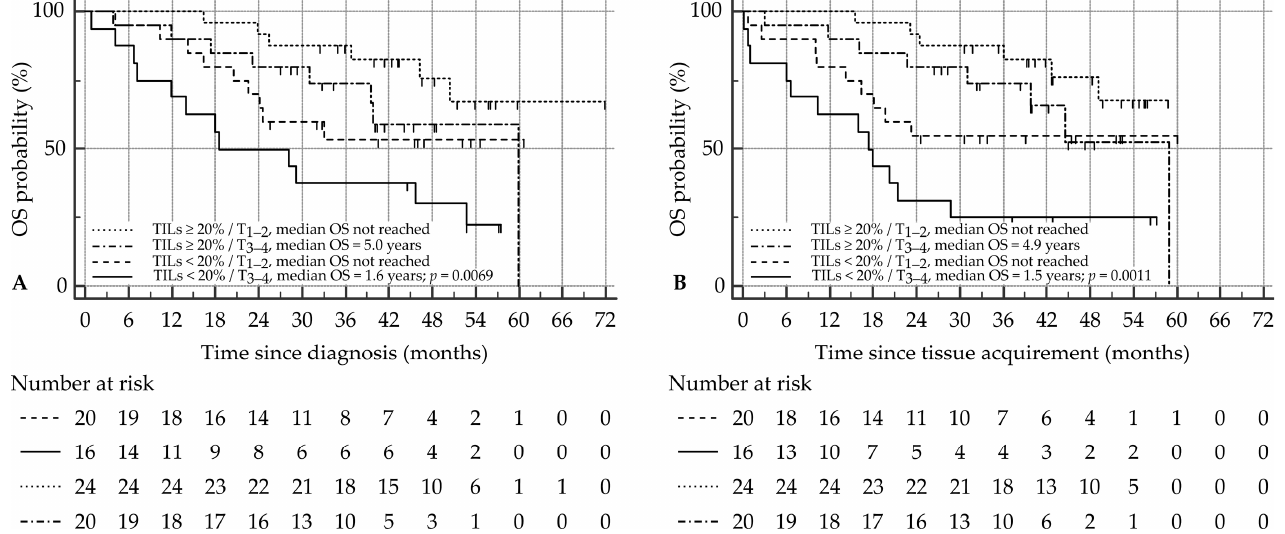
Figure 4. Effect of combination of T stage and TIL count on OS in SCCHN patients. x -axis depicts survival time (in months), y -axis depicts the cumulative OS probability. Survival curves are depicted for ( A ) OS since diagnosis and ( B ) OS since time of tissue acquirement. Number at risk for each group is indicated beneath each OS curve. HR, hazard ratio; OS, overall survival; SCCHN, squamous cell carcinoma of the head and neck; TILs, tumor-infiltrating